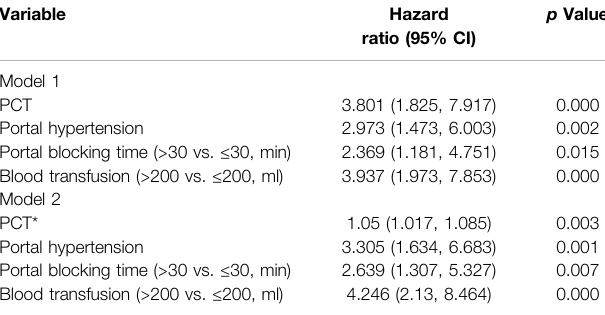
TABLE 3 | Multivariate analyses for risk factors associated with PHLF. Variable